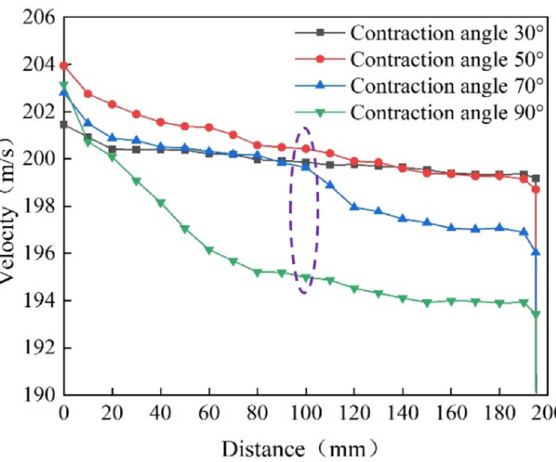
Figure 4. Effect of contraction angle on the X-axis velocity attenuation of water jet.